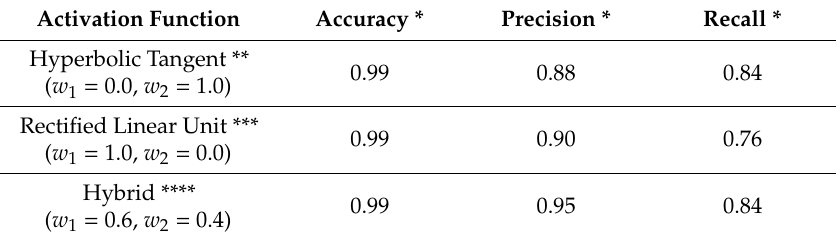
Table 13. The results of the classification evaluation according to the activation function. Activation Function Accuracy * Precision * Recall * Hyperbolic Tangent